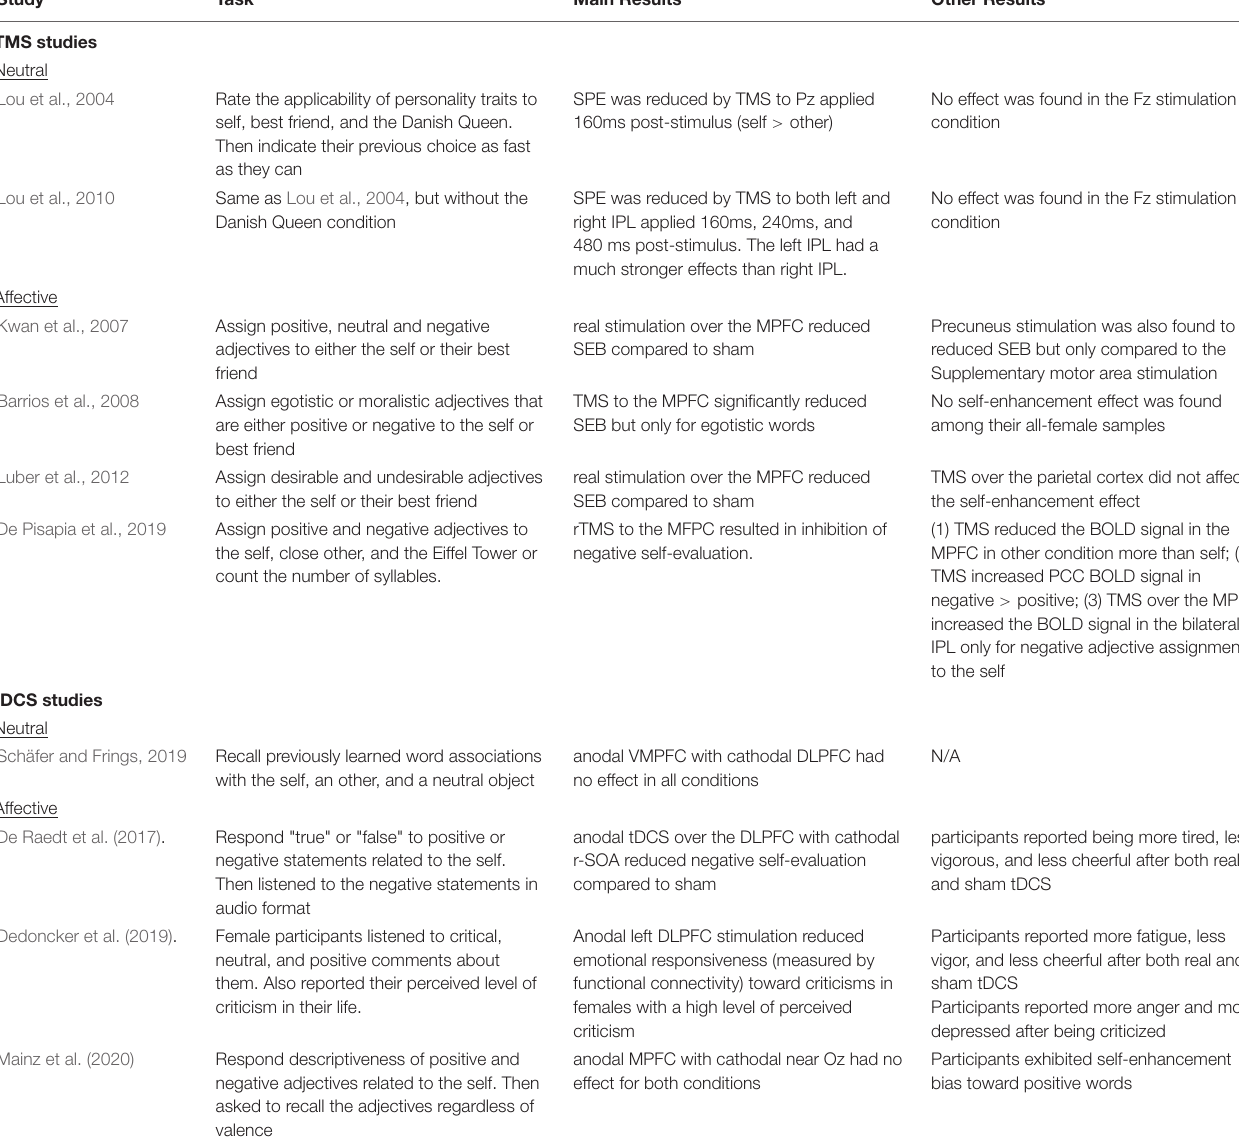
TABLE 3 | Summary of results of the included V-SRP